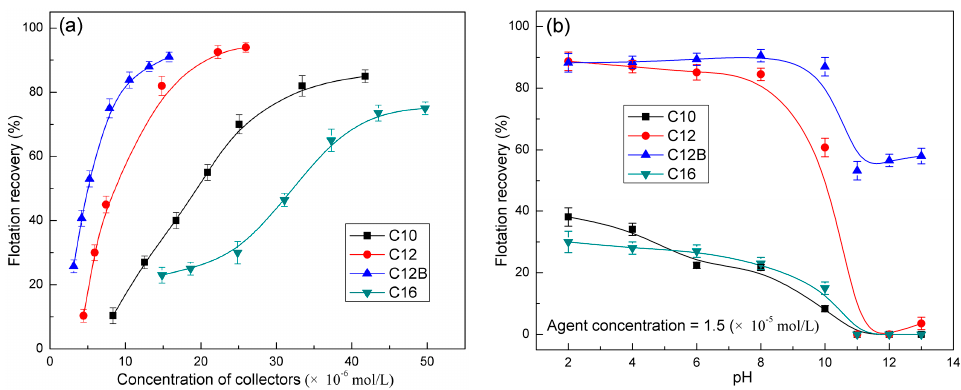
Figure 3. Using different sulfonate-based collectors, the effects of ( a ) the collectors’ concentration and ( b ) of their pH on the flotation performance of fluorite.